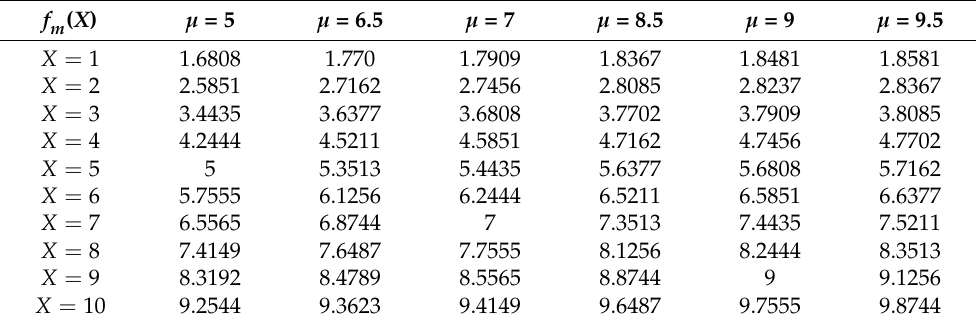
Table 6. Dependence of the function f m ( X ) value on the mean of f ( θ ) and the grade X in case 5.